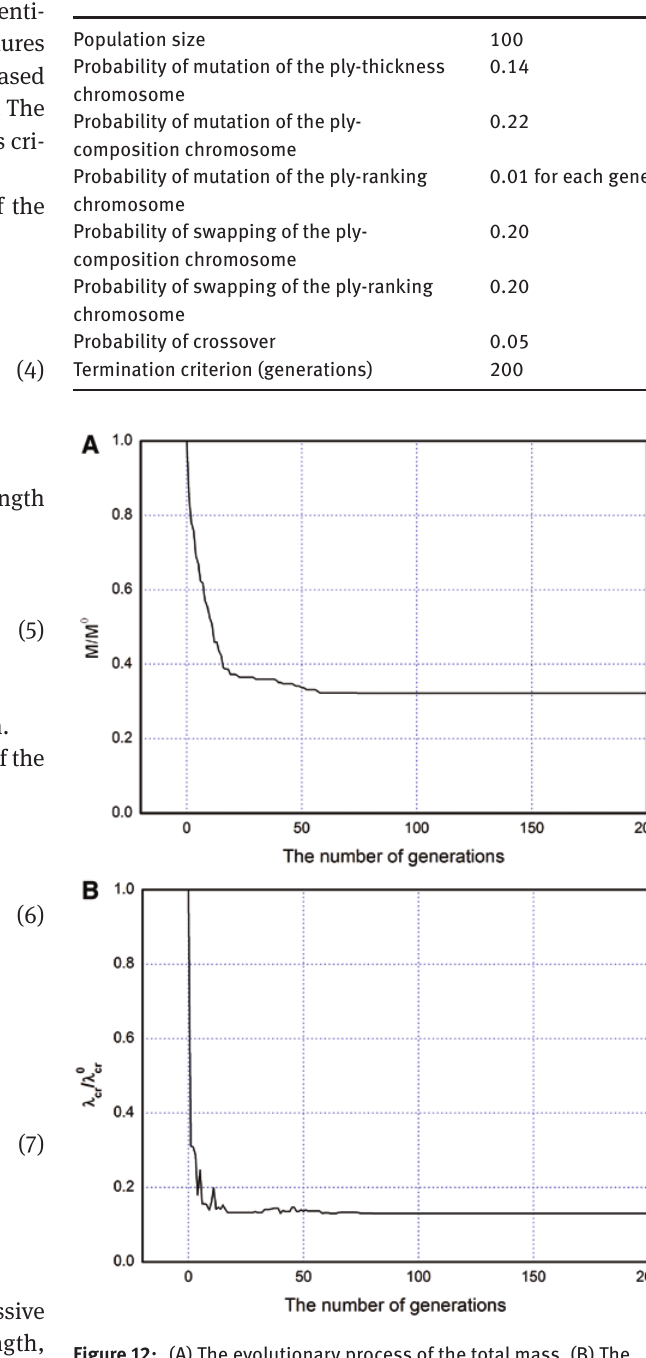
Figure 12: (A) The evolutionary process of the total mass. (B) The evolutionary process of the critical factor. The evolutionary process of design solutions with identical core